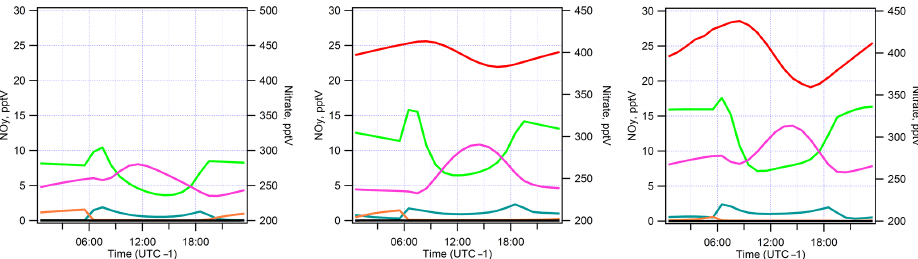
Figure 10. Shown are NO y diurnals for the CVO site during summer months in the base scenario (left), with HOI + NO 3 chemistry included (centre), and with HOI and HOBr + NO 3 chemistry included (right). BrONO 2 – green; IONO 2 – teal; PAN – pink; NO 3 – orange; N 2 O 5 – black; p -NO 3 – red.